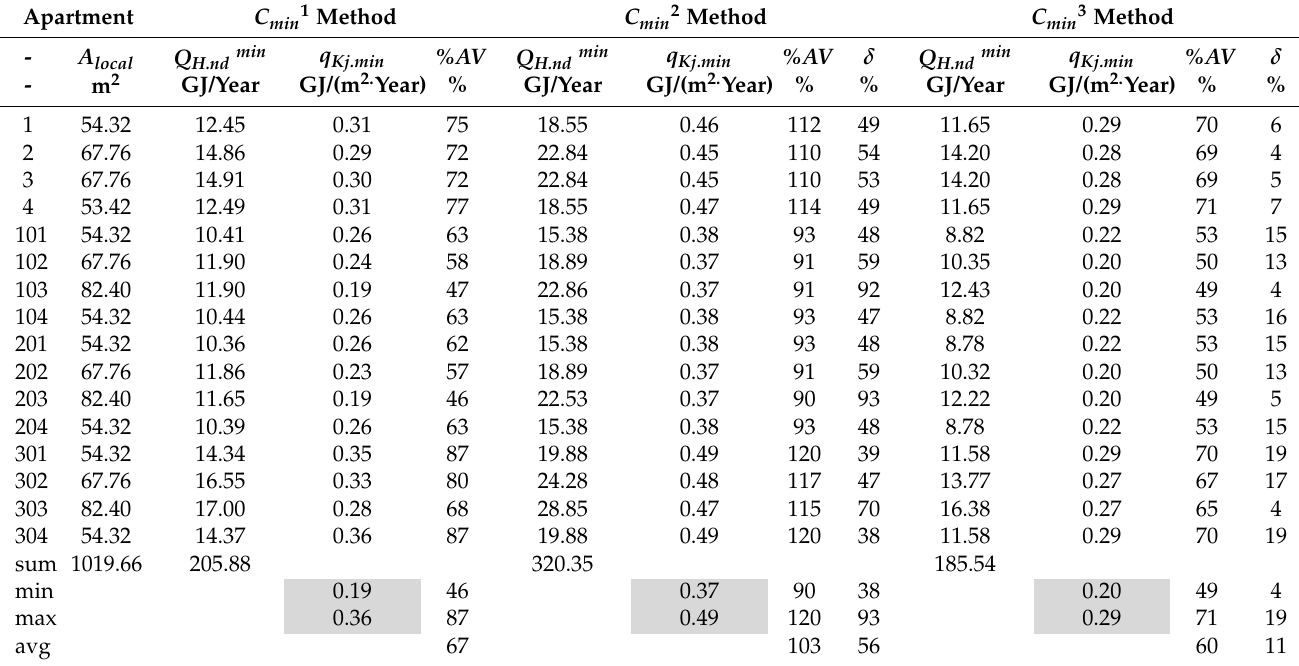
Table A3. The results of the unit minimum final energy consumption in the individual apartments of the analyzed building after